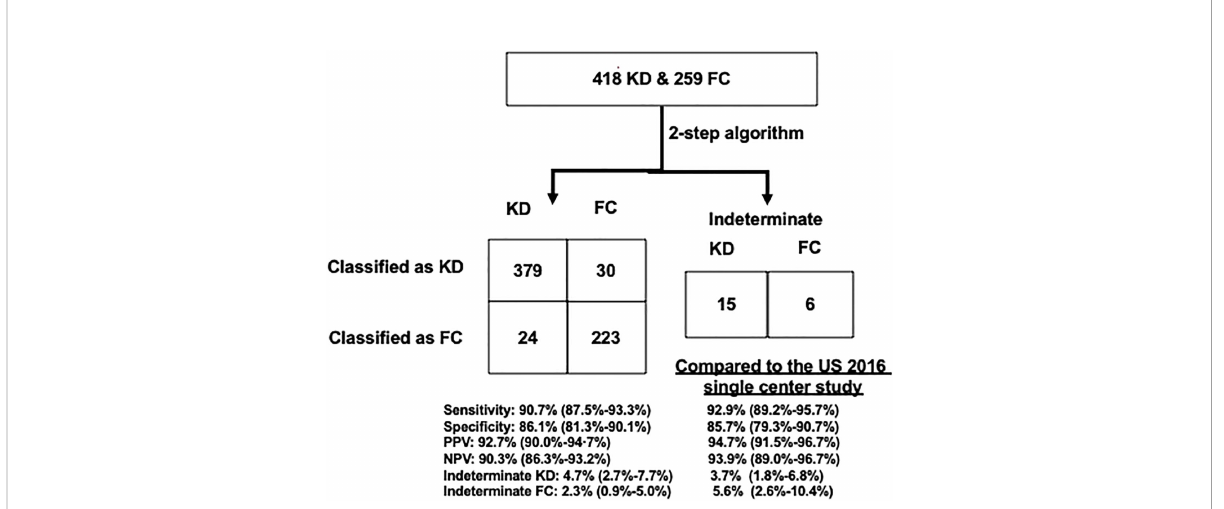
FIGURE 2 Performance of the US validated KD algorithm to diagnose KD from FC patients. Left: a 2×2 table compared with US single-center validation results. The US cohort was described in 2016 Hao et al. publication. Right: percentages of correctly classi fi ed, misclassi fi ed, and indeterminate patients. FCs, febrile controls; KD, Kawasaki disease; NPV, negative positive value; PPV, positive predictive